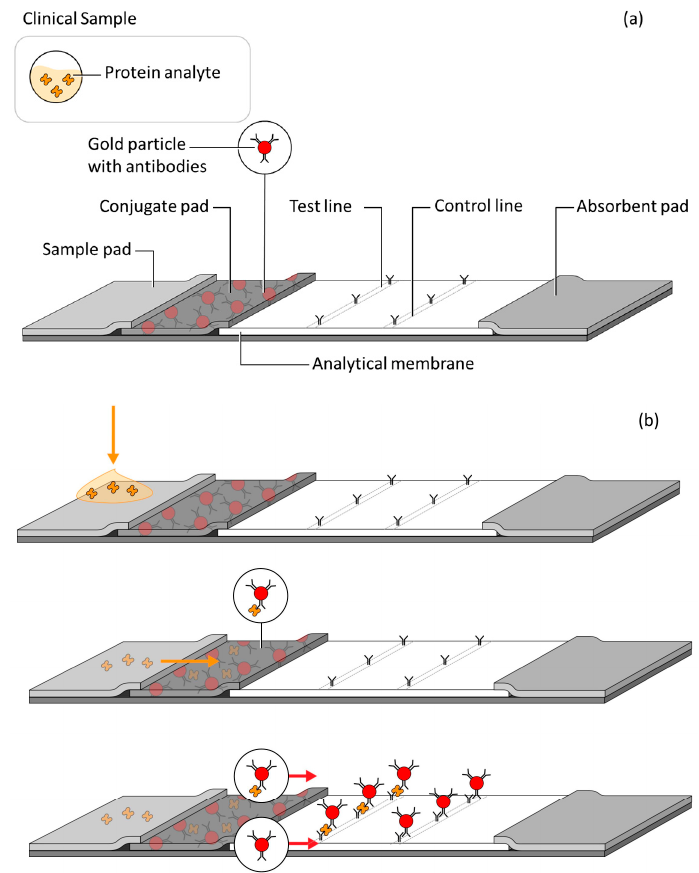
Figure 1. ( a ) Component parts of lateral flow assay strip; ( b ) development of a lateral flow assay test. Yellow arrows indicate the application and flow of the sample; red arrows indicate the flow of the detector nanoparticle.